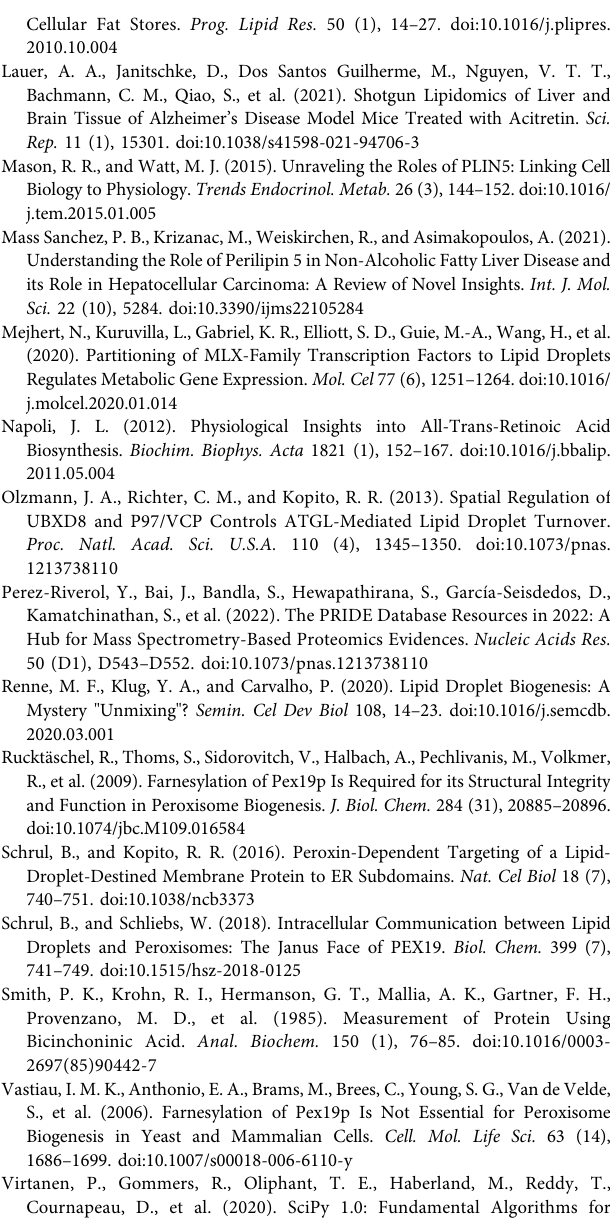
Supplementary Table 1 | Excel fi le with lipidomics data. Supplementary Table 2 | Excel fi le with proteomics